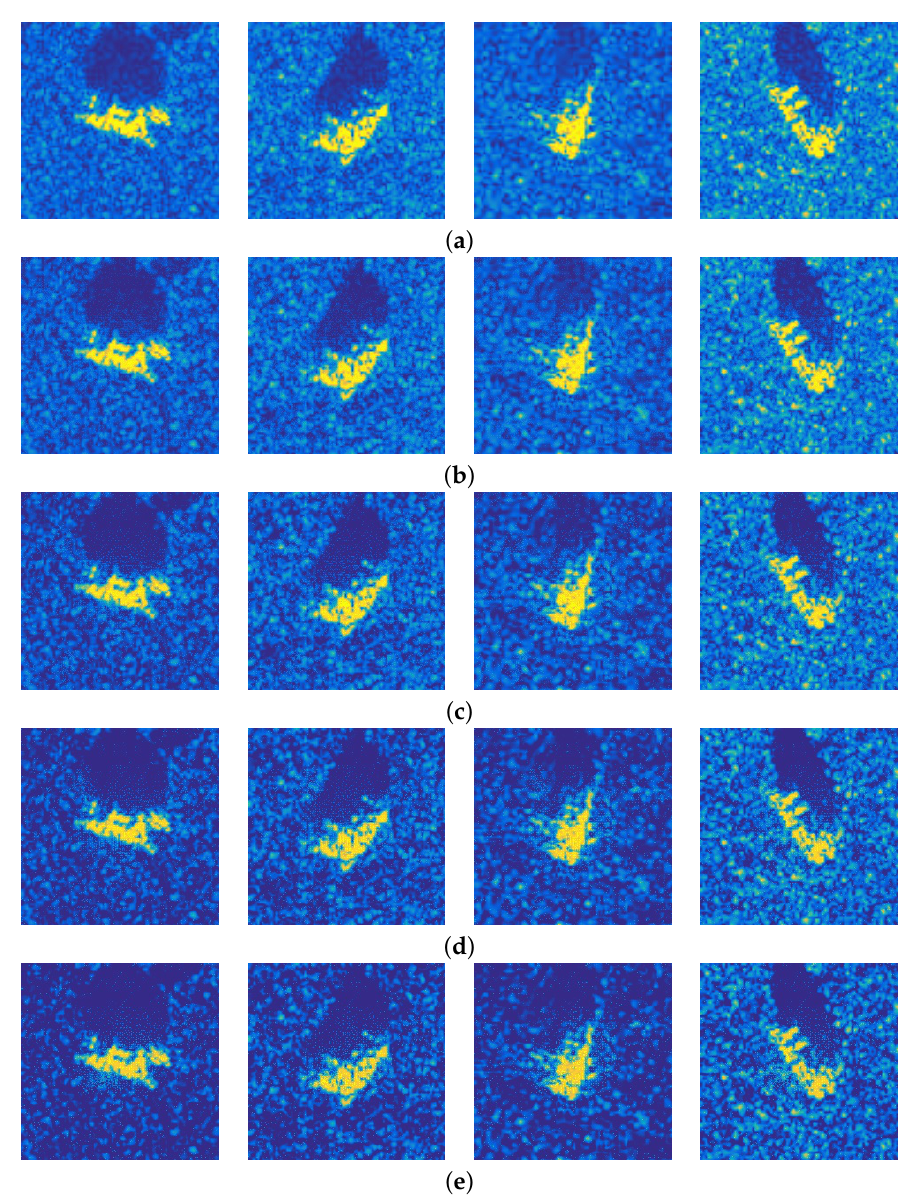
Figure 6. Adversarial examples with various l ∞ constraint (cid:101) . ( a ) Ori. ( b ) (cid:101) = 8/255. ( c ) (cid:101) = 16/255. ( d ) (cid:101) = 24/255. ( e ) (cid:101) =